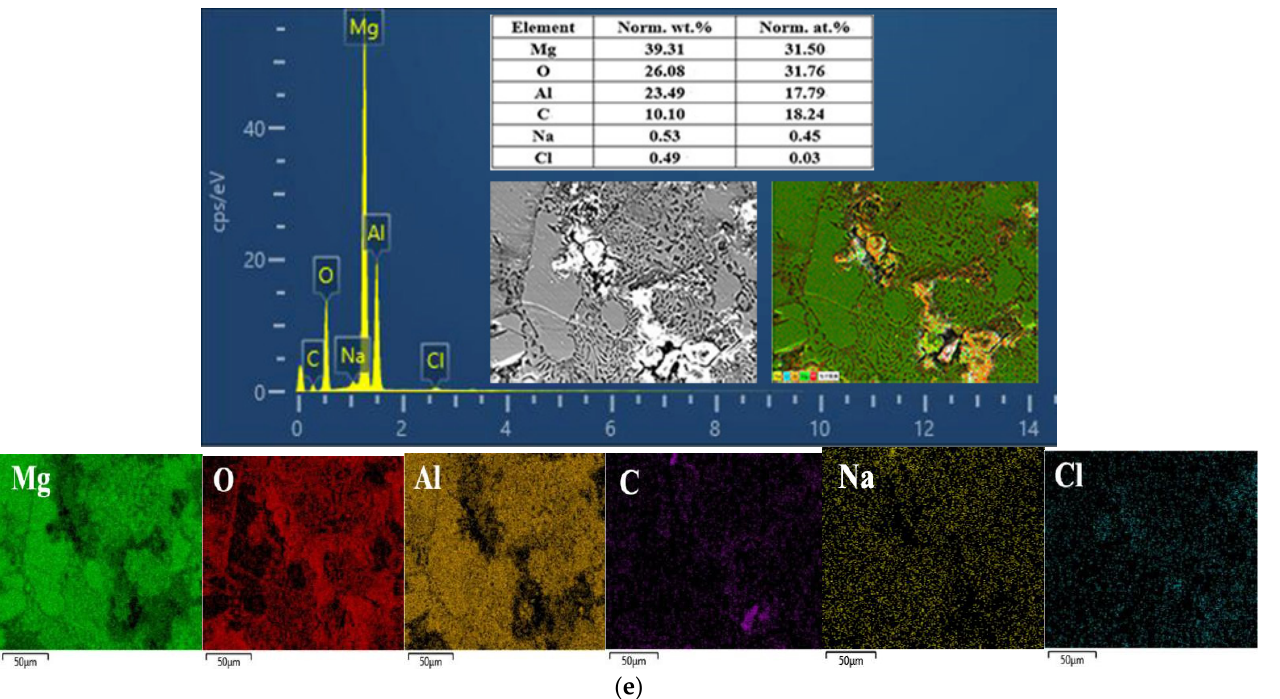
Figure 9. EDS spectrum and the composition and distribution of elements in the ( a ) Al1060, ( b ) Mg1, ( c ) Mg 2 Al 3 layer, ( d ) Mg 17 Al 12 layer, and ( e ) Mg 17 Al 12 and Mg-based solid solution layer.